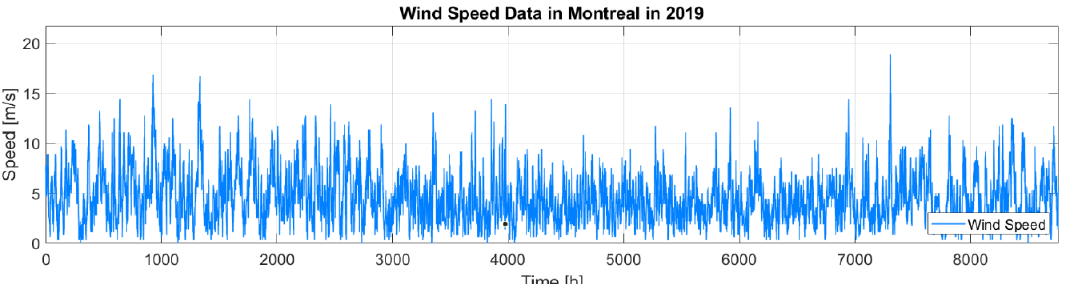
Figure 4. Wind Speed data in Montreal for the year 2019.